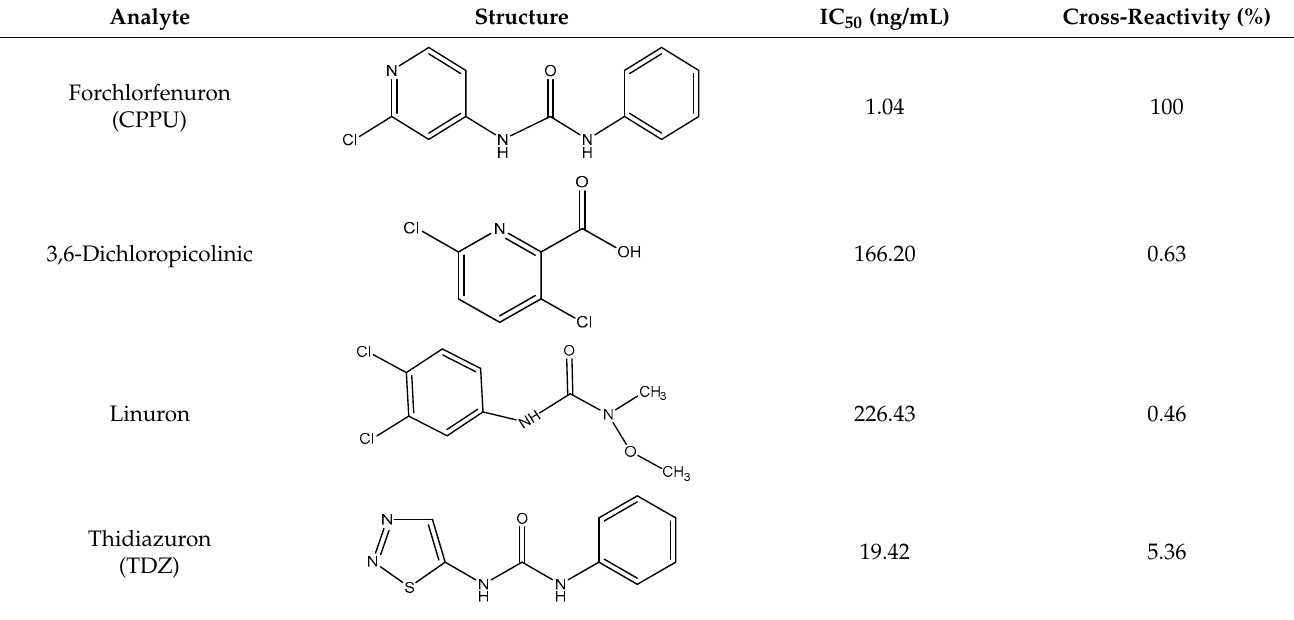
Table 2. Cross-reactivity of CPPU and other structural analogues.